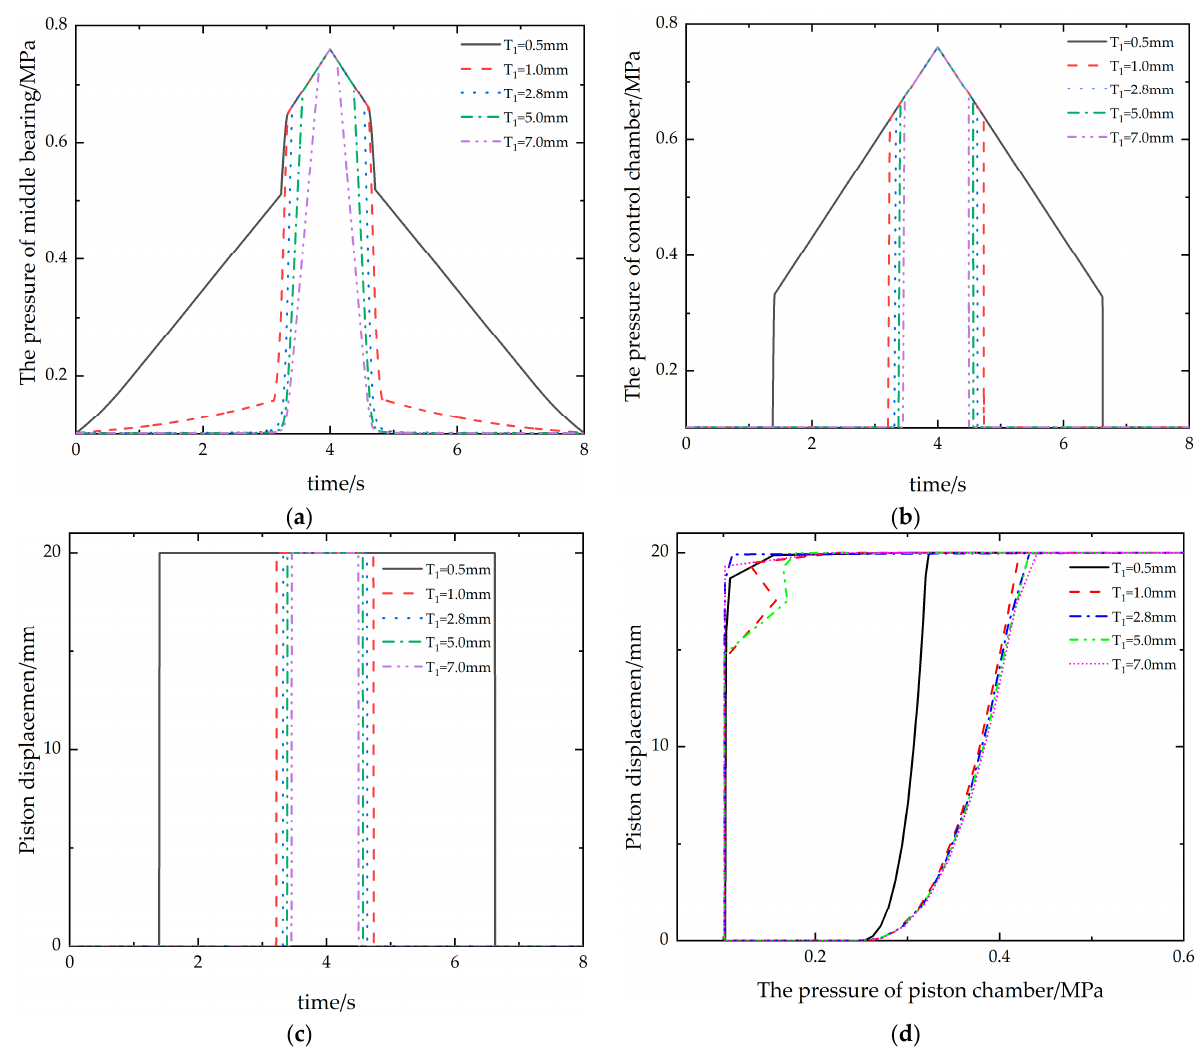
Figure 14. Opening and closing characteristics of valve with different middle nozzle diameters: ( a ) The variation law of middle bearing pressure with time; ( b ) Control of the change in cavity pressure with time; ( c ) The variation law of piston displacement with time; ( d ) The variation of piston displacement with pressure in control